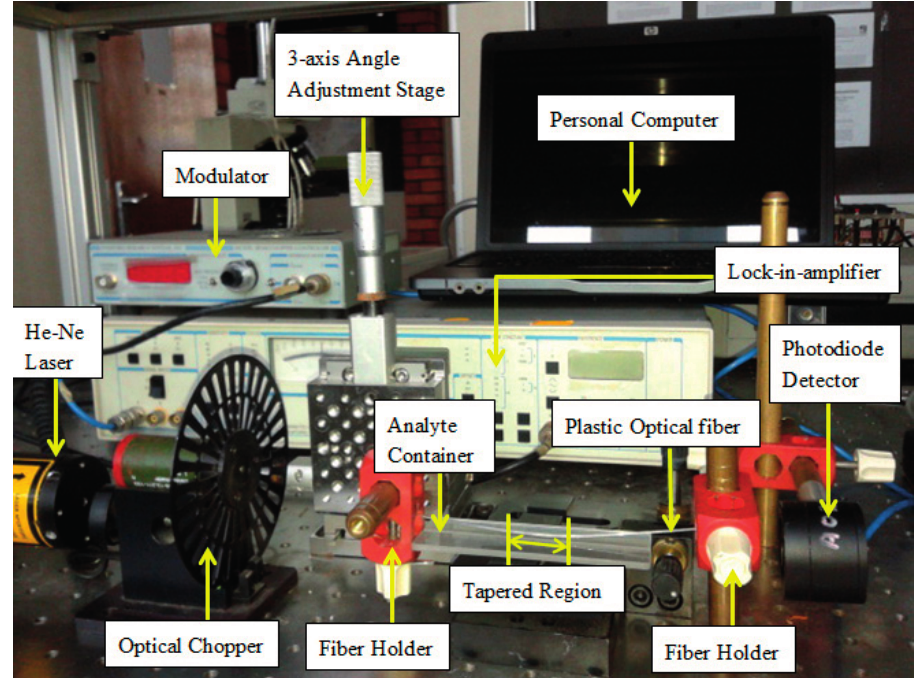
Figure 2. The tapered POF based sensor system for RBB concentration